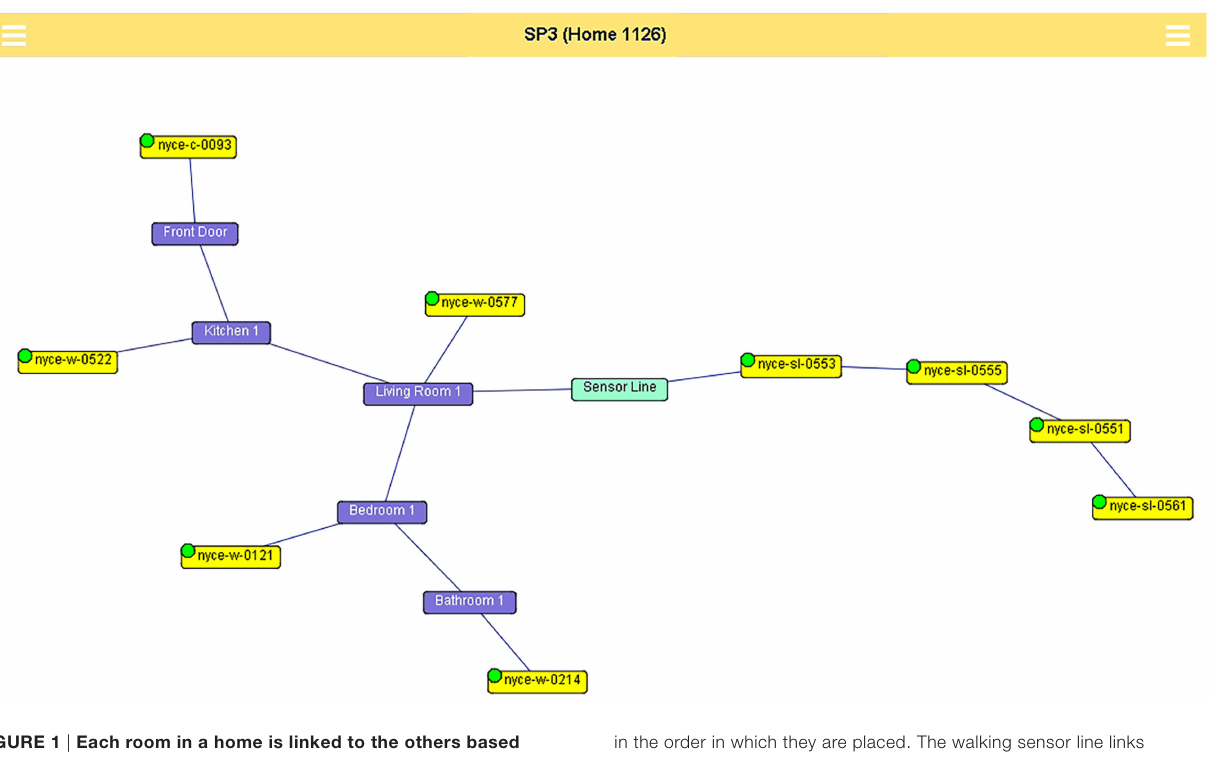
in the order in which they are placed. The walking sensor line links room(s) in which the sensors are located. Green or red dots on the sensor nodes indicate if the sensor is currently reporting in to the sensor